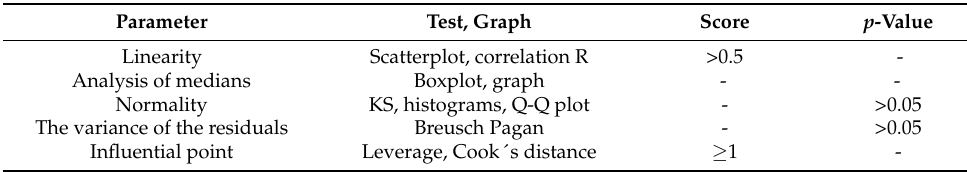
Table 2. Model assumptions